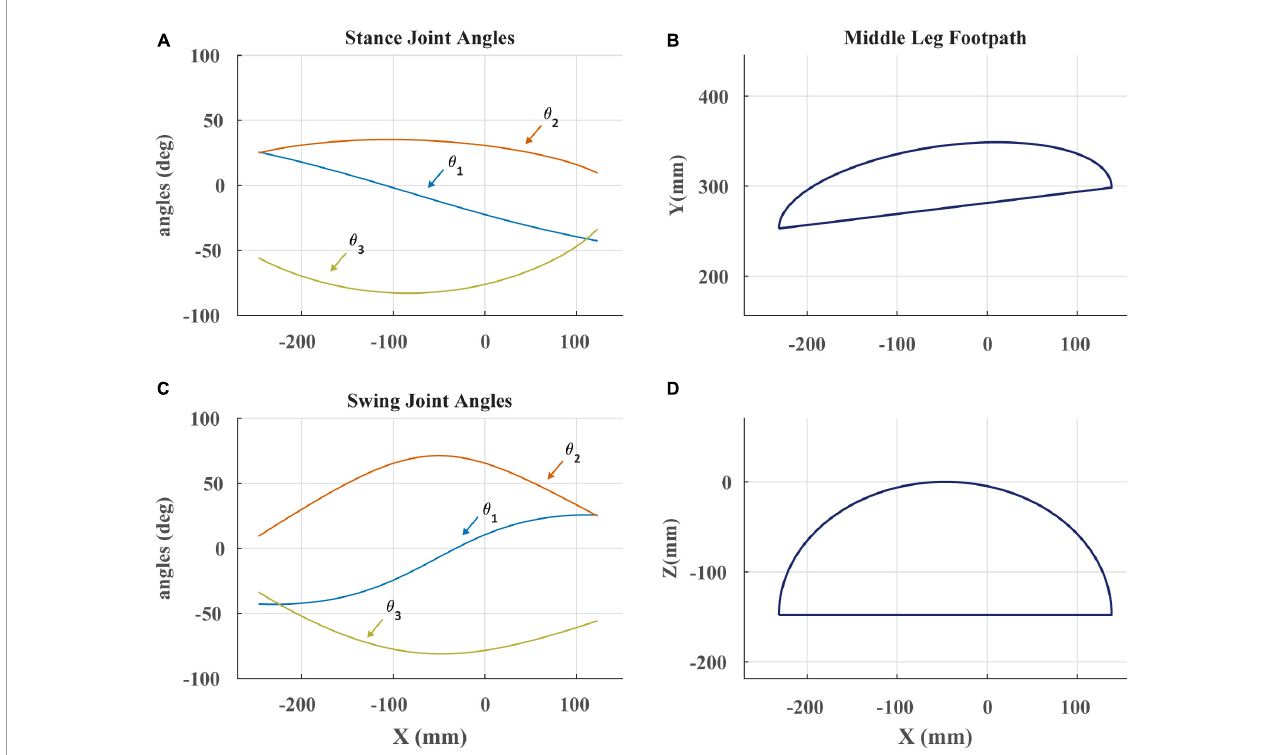
FIGURE3 (A) Stance angles of robotic leg plotted against the x-coordinate of the foot in space as in Cruse and Bartling (1995). The x-coordinate is the anterior-posterior position of the foot. θ 1 is the ThC joint, θ 2 is the CTr joint, and θ 3 is the FTi joint. (B) The projected footpath of the scaled C. morosus footpath in the x-y plane. The y-coordinate is the lateral position of the foot. (C) Swing joint angles of robotic leg plotted against the x-coordinate of the foot in space. (D) The projected footpath on the x-z plane. The z-coordinate is the dorso-ventral position of the